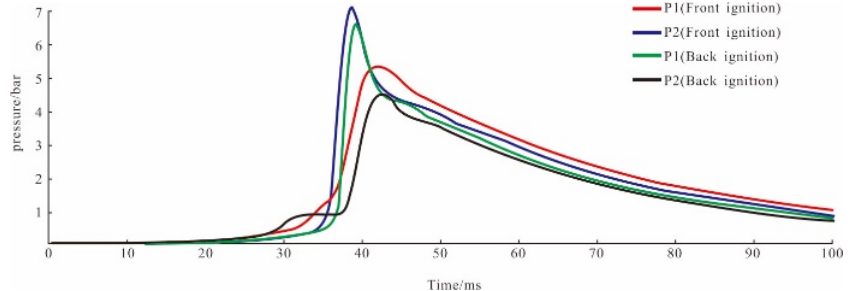
Figure 8. Pressure-time profile for sample 2.